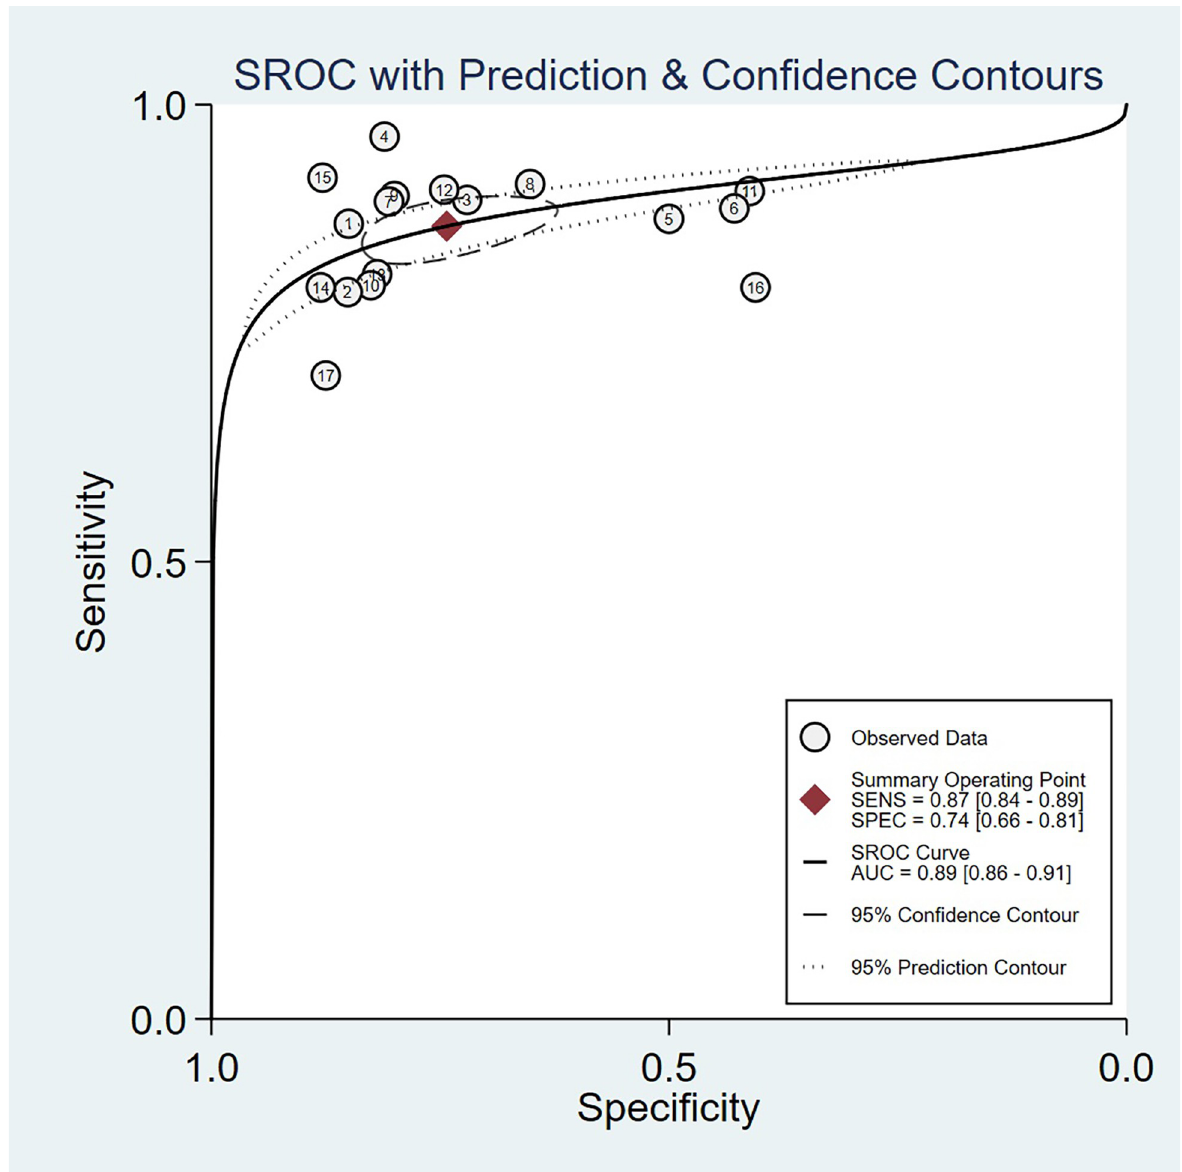
Fig 6. SROC curve of S-Detect diagnostic accuracy obtained in this